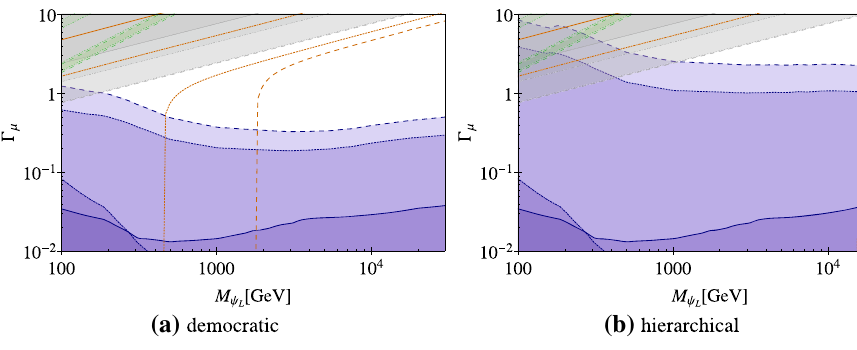
Fig. 6 Summary plot for Majorana DM in bIIA. The legend and an explanation of the color scheme are given in